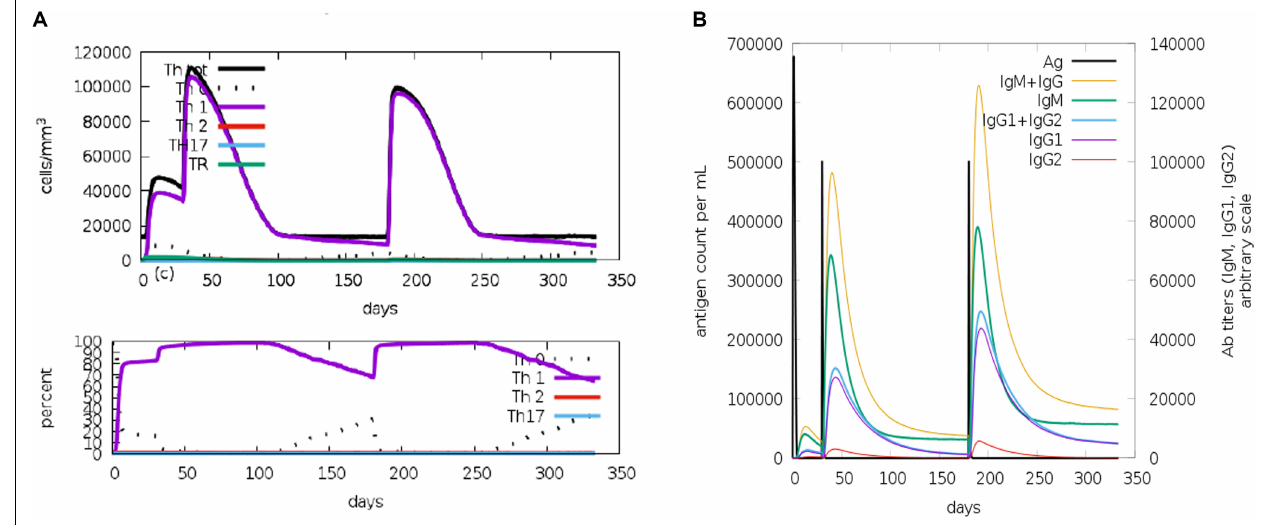
FIGURE 5 | C-ImmSim representation of the immune stimulation of the designed virus-like particle (VLP)-based vaccine. (A) Phenotypic evaluation of T helper cells against a vaccine injection. (B) Generation of immunoglobulins in response to vaccine injections (0, 1, and 6 months). Specific subclasses are demonstrated as colored peaks